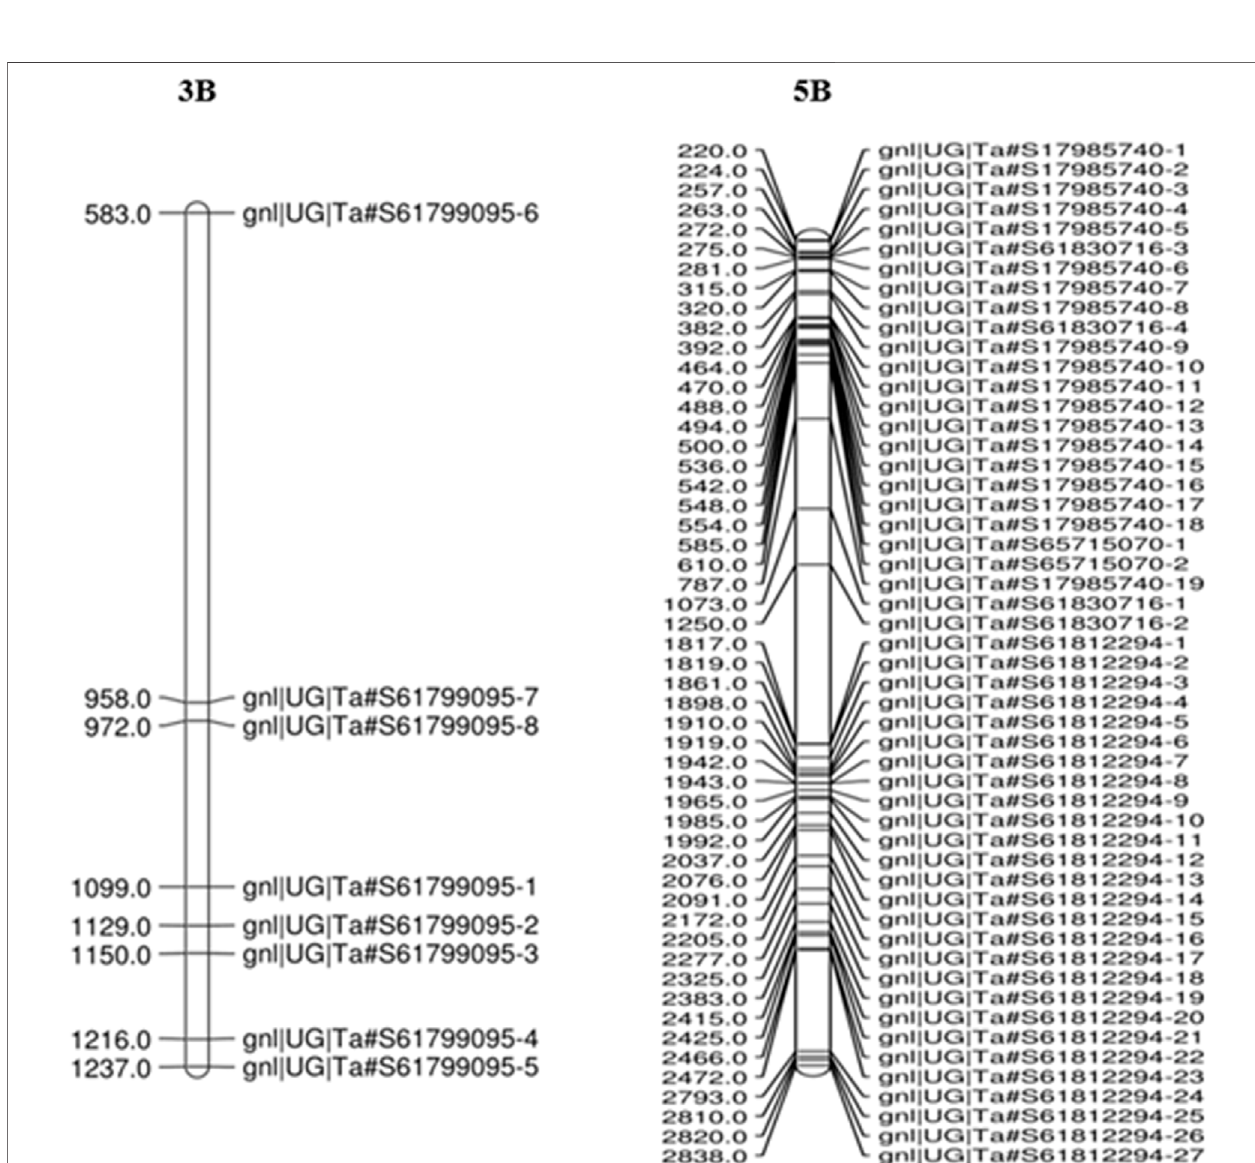
FIGURE 5 | The distribution of 60 polymorphic SNPs linked to SB resistance on the wheat chromosome derived from the RIL population. The eight SNPs present on 3B and 52 SNPs on 5B chromosomes indicate their relative position.